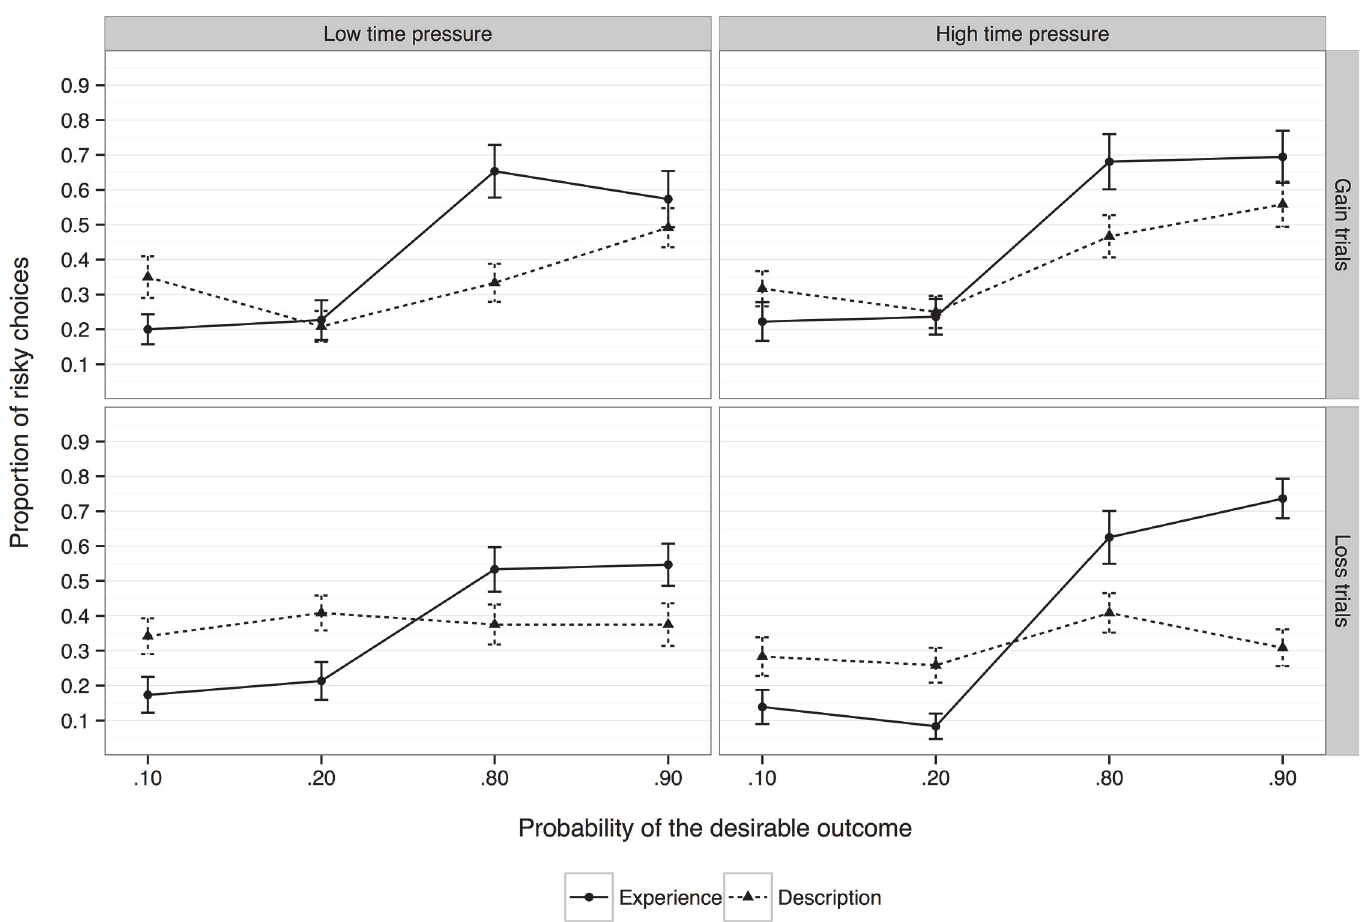
Fig 4. Comparison of choice proportions between conditions (description vs. experience) as a function of time pressure condition and choice framing.